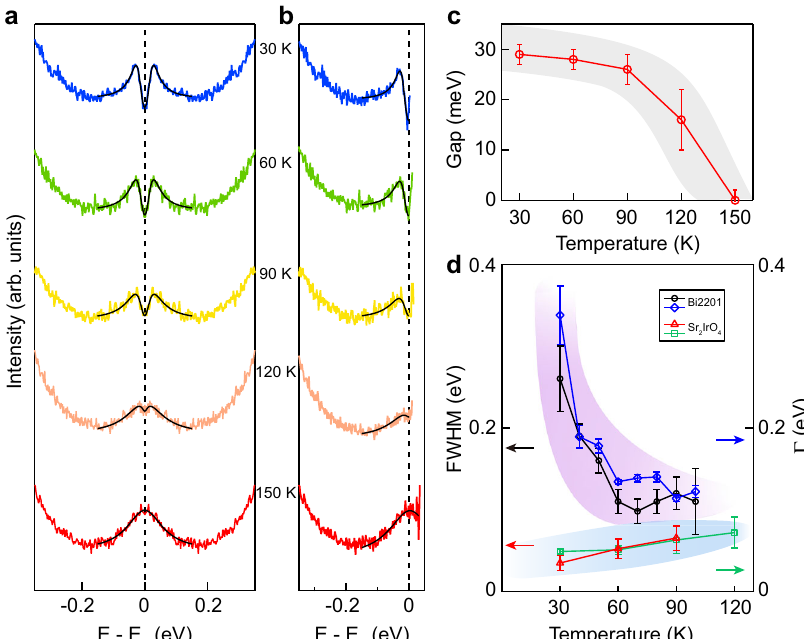
Fig. 2 Temperature evolution of the EDC at the Fermi momentum. a , b The symmetrized ( a ) and Fermi – Dirac-function-divided ( b ) EDC at the Fermi momentum K F 1 (de fi ned in Fig. 1), measured at selected temperatures. Fitting results are shown as black lines. The observed quasiparticle peaks at low temperature enable a quantitative determination of the gap. c Gap magnitude as a function of temperature. The gray shading is a guide to the eye. d Extracted FWHM of the EDC peak (red triangles) and the single-particle scattering rate ( Γ ) from the fi ts (green rectangles) are presented as a function of temperature. The same quantities for Bi2201 are extracted from ref. 10 and shown here (black circles and blue diamonds) for comparison. Note that the fi tting parameter Γ is only used as an independent but empirical estimation of the EDC peak width; this phenomenological model might not be suf fi cient to describe the experimental spectra and the results of ref. 10 . The error bars represent the uncertainty in extracting the FWHM of the EDC peak and in the fi tting